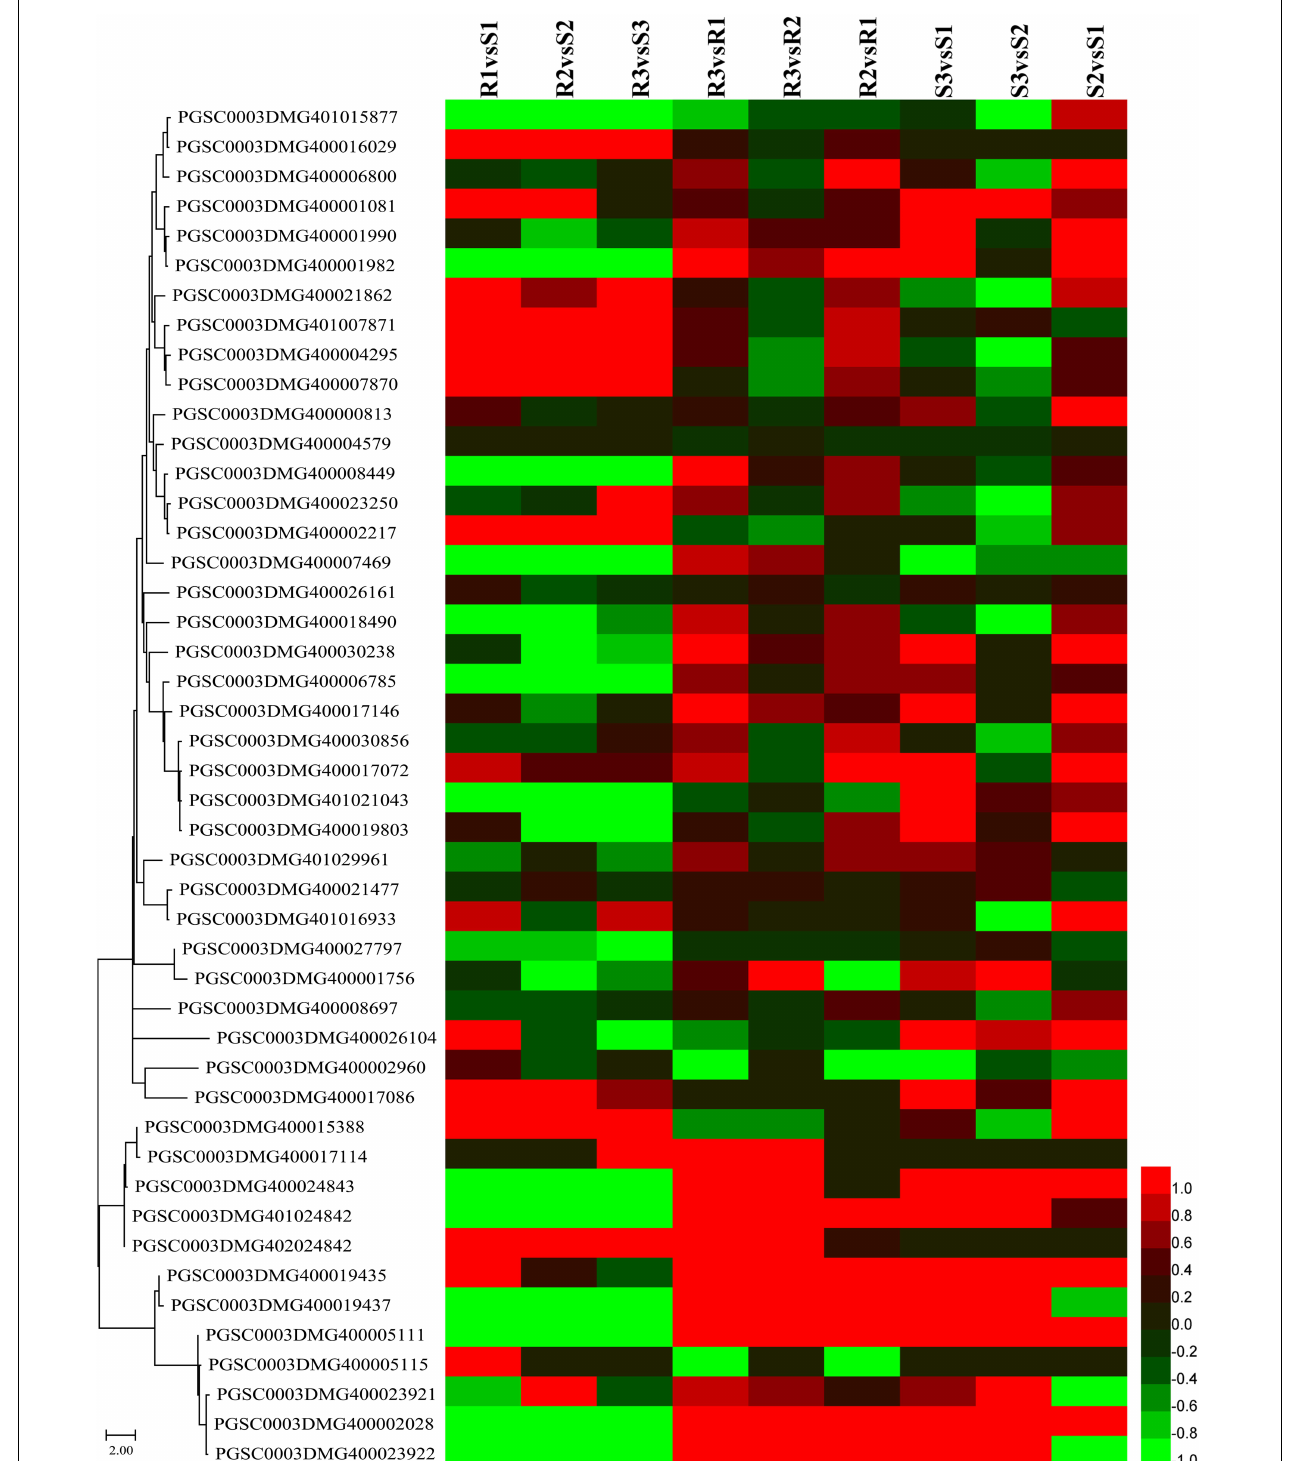
FIGURE 6 | Expression patterns of nucleotide-binding site-leucine-rich repeat (NBS-LRR) and pathogenesis-related protein-encoding genes. Sequences of NBS-LRR and pathogenesis-related proteins were submitted to MEGA 11 to draw a neighbor-joining tree (Tamura et al., 2021). The log 2 FC values of the encoding genes of these proteins were calculated based on the expression levels and used to draw heatmaps by HemI (version 1.0) (Deng et al., 2014). From top to bottom, PGSC0003DMG401015877 to PGSC0003DMG400017086 are NBS-LRR genes and PGSC0003DMG400015388 to PGSC0003DMG400023922 are pathogenesis-related protein-encoding